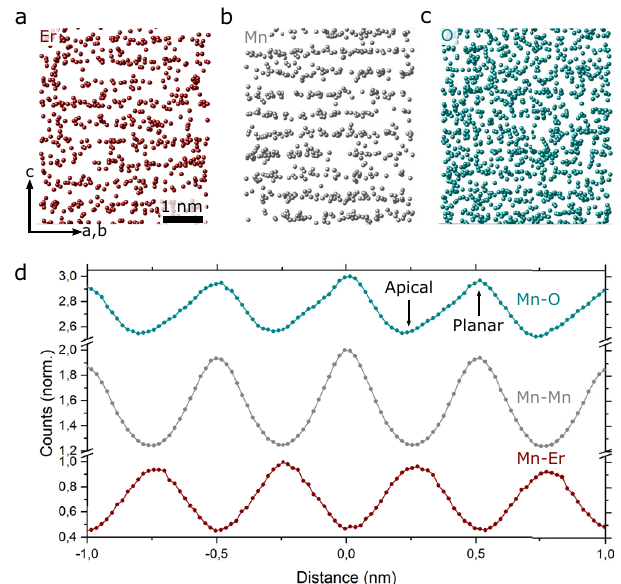
Fig. 2 | 3D imaging of the Er, Mn, and O lattice atoms in Er(Mn,Ti)O 3 . a APT reconstruction showing the Er lattice planes (Er 3+ , Er 2+ , ErO 2+ , and ErO + ) from a region in the pole (see Supplementary Fig. 8). The volume is oriented so that the layered structureof Er atoms along the crystallographic c -axis isvisible, consistent withTEM data (Supplementary Fig. 9). b , c Sameasin a for Mn(Mn 2+ and Mn + )and O (O + ) atoms, respectively. d SDMs of the lattice atoms, showing the distance between Mn and O (Mn-O) and Mn and Er (Mn-Er) with Mn serving as reference